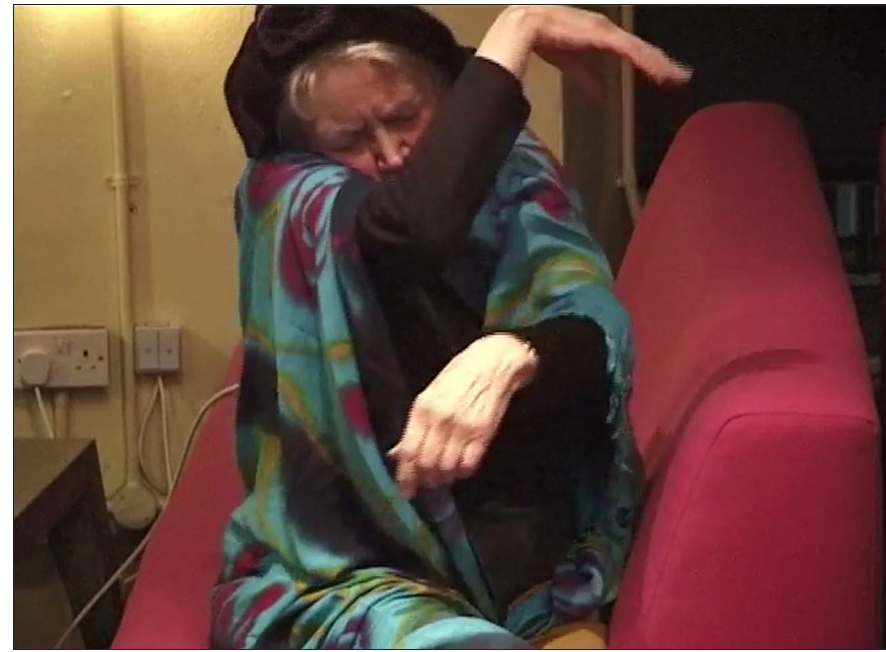
Figure 2.5: (50.23) Jennifer Pike with Birdyak at the RCA, London 2002. Courtesy of William